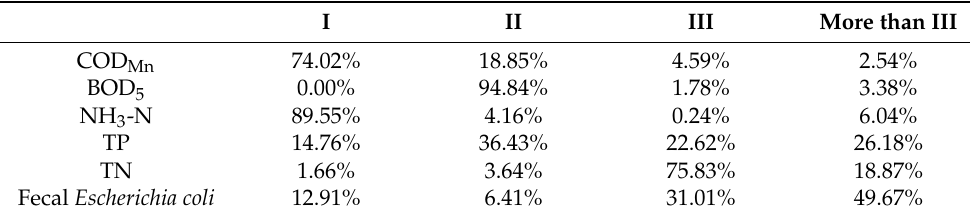
Table 2. Proportion of water quality indicator monitoring data within the different classes of China Surface Water Environmental Standards